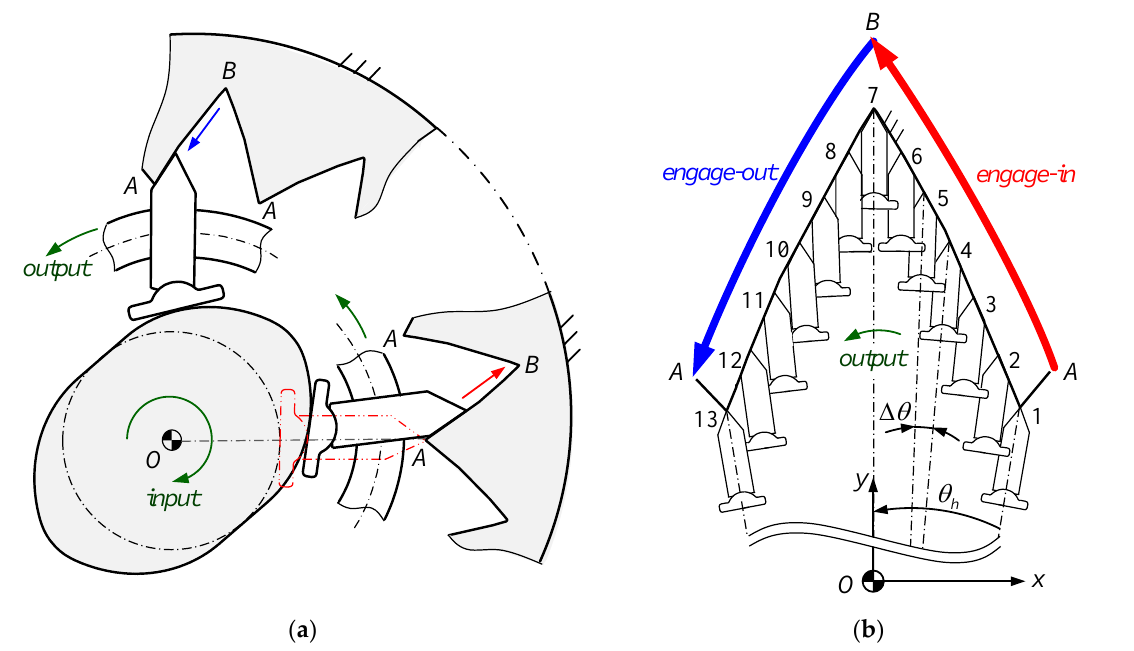
Figure 3. Transmission principle. ( a ) a meshing period of conjugate tooth profile; ( b ) multi-tooth meshing phase relation.